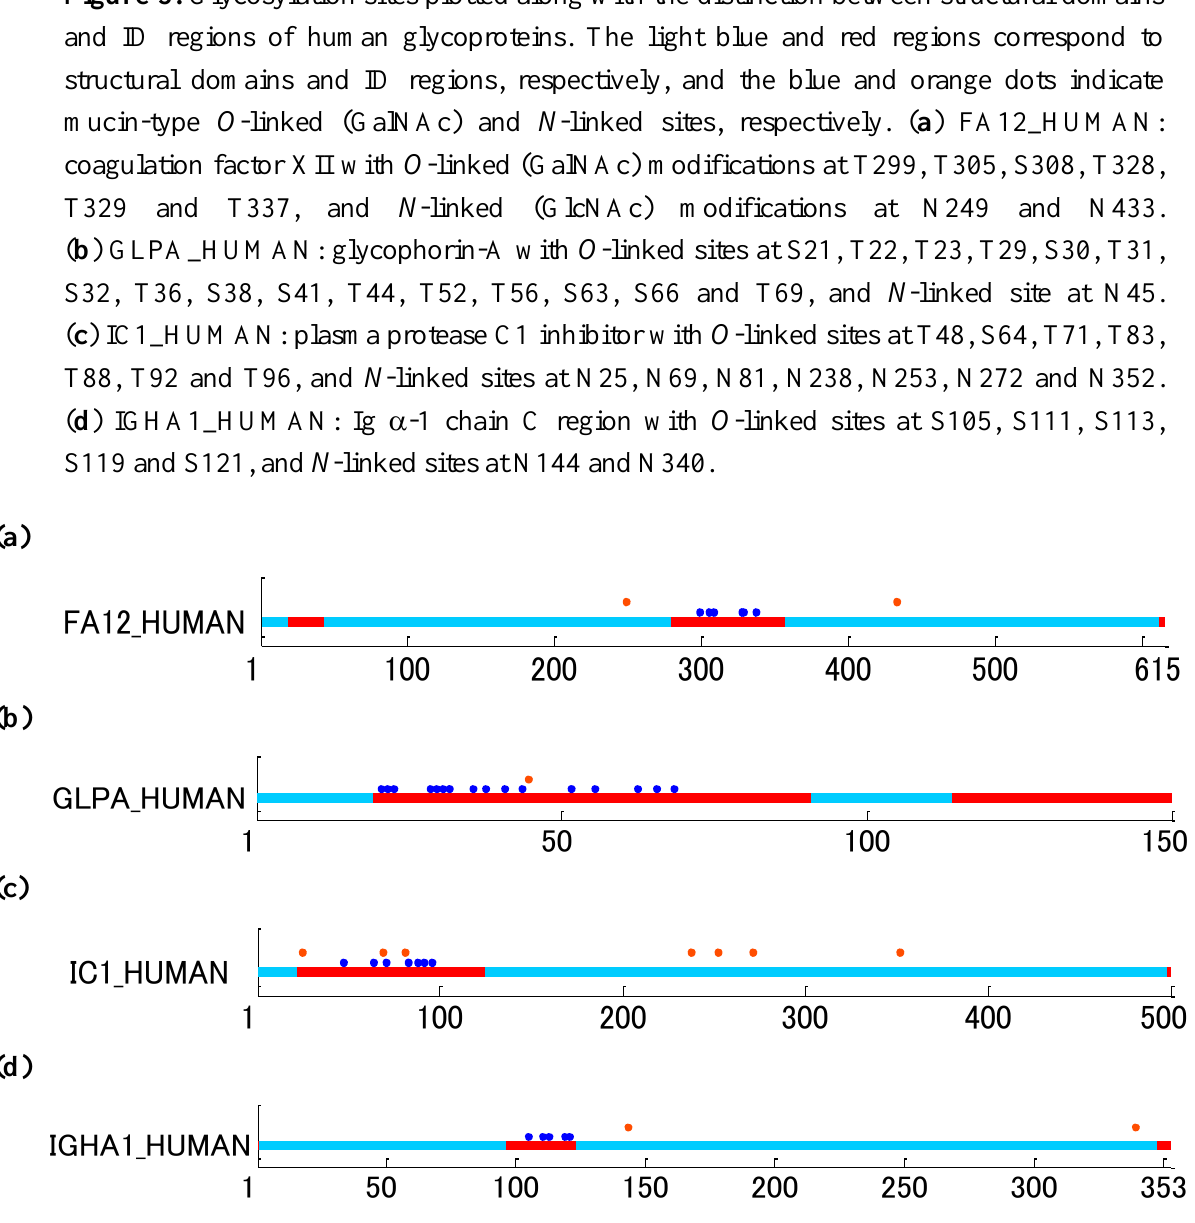
Figure 5. Glycosylation sites plotted along with the distinction between structural domains and ID regions of human glycoproteins. The light blue and red regions correspond to structural domains and ID regions, respectively, and the blue and orange dots indicate mucin-type O -linked (GalNAc) and N -linked sites, respectively. ( a ) FA12_HUMAN: coagulation factor XII with O -linked (GalNAc) modifications at T299, T305, S308, T328, T329 and T337, and N -linked (GlcNAc) modifications at N249 and